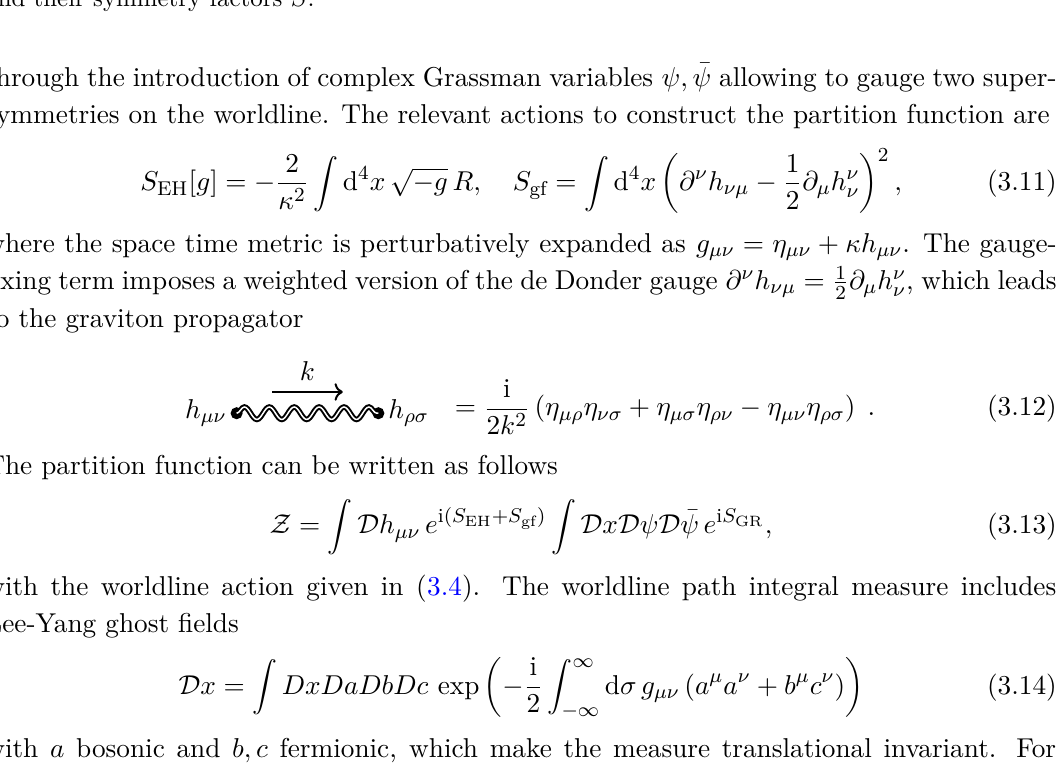
Figure 3. Examples of worldline topologies required for the calculation of 7-point sQED current and their symmetry factors S